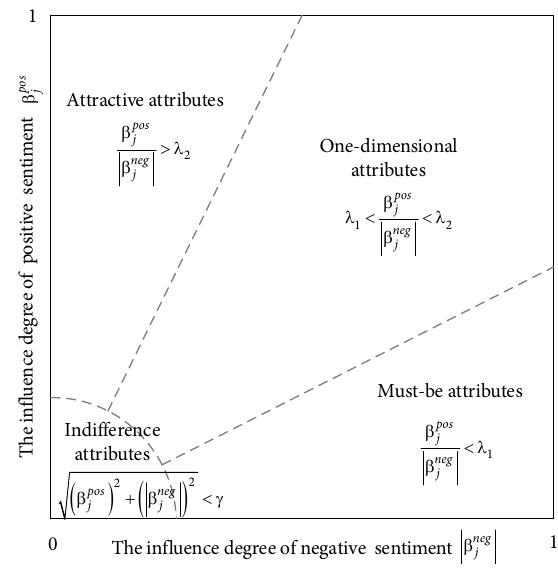
Figure 11. Attribute types division based on the sentiment